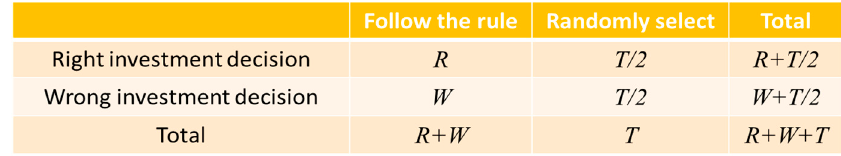
Figure 2. Pattern of factor’s change.